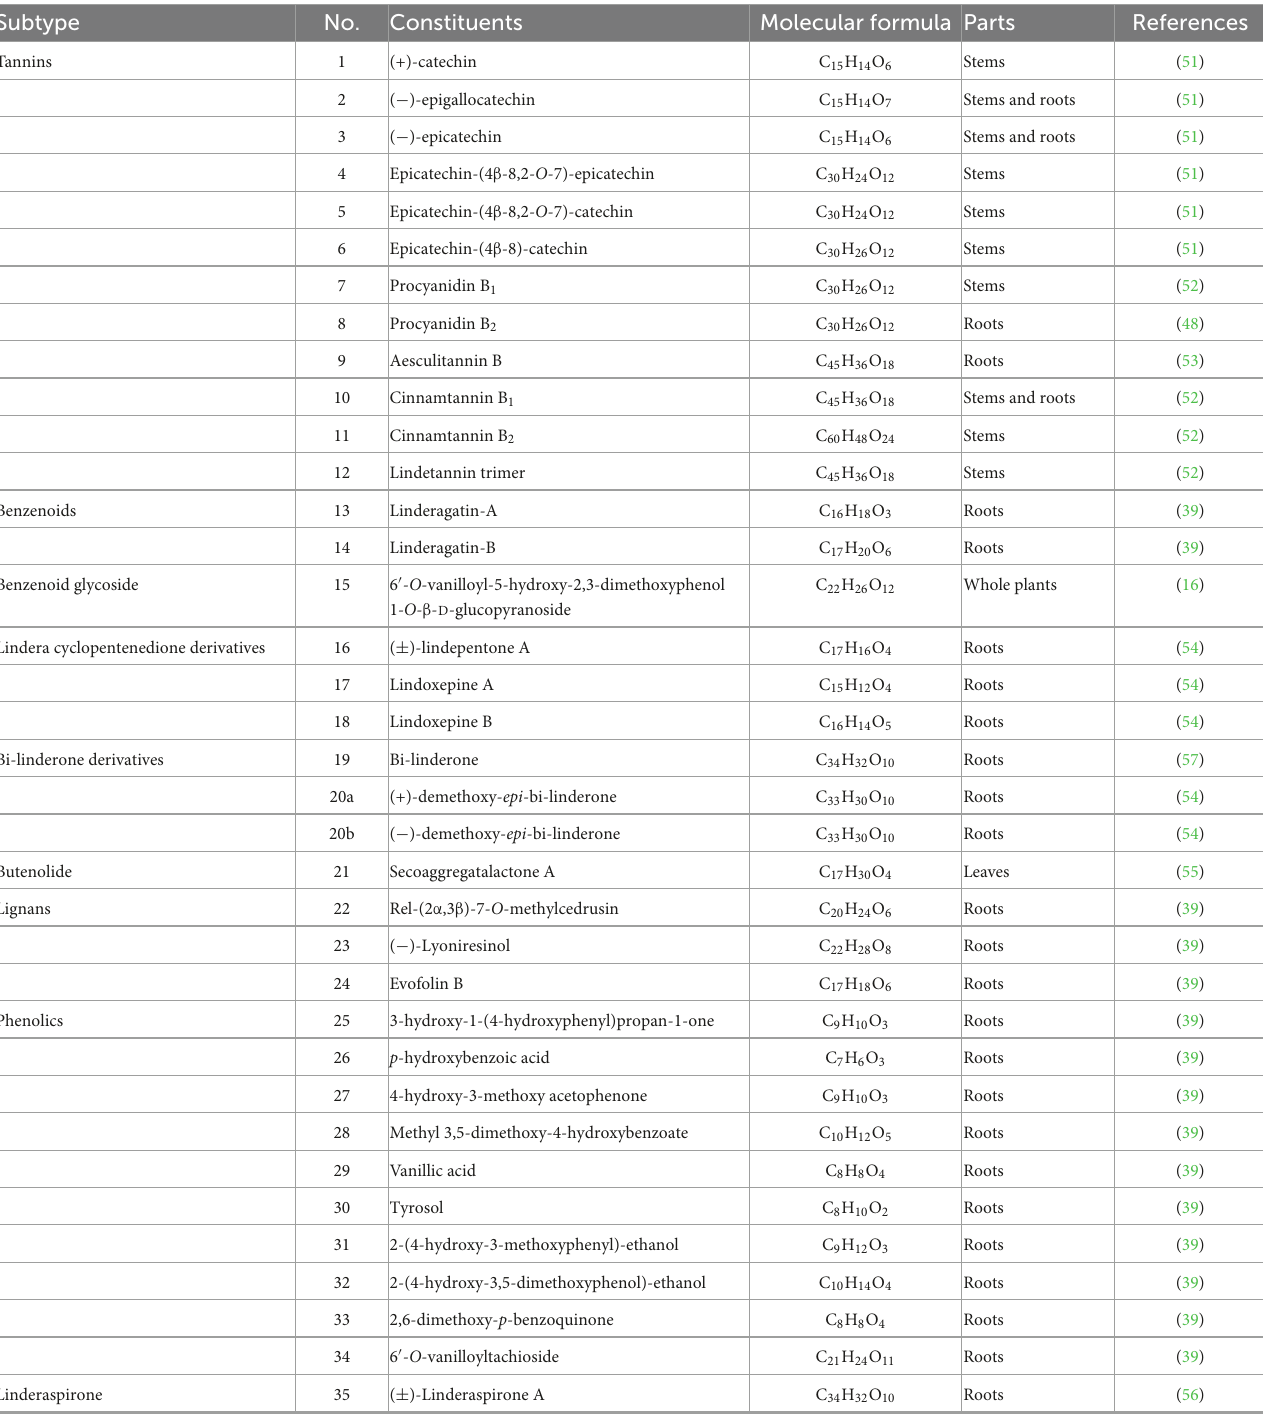
TABLE 4 Other components isolated from L.